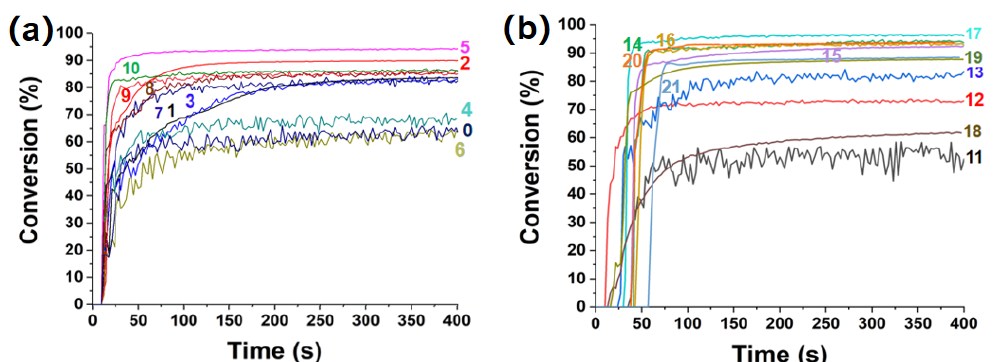
Figure 1. Photopolymerization profiles of Ebecryl 40 (conversion rate of C = C bonds vs irradiation time) initiated by iodonium (Iod) and amine (EDB) upon exposure to LED@405nm under air in the presence of dyes 1 – 21 for curves 1–10 ( a ) and 11–21 ( b ) at the same weight ratio: dye:Iod:amine = 0.1%:2%:2% in Ebecryl 40; the curve number indicated the investigated dye. The reference curve without dye is curve 0 for Iod:amine = 2%:2%. The irradiation starts for t = 10 s. Table 1. Summary of the final acrylate function conversions (FCs) at 405 nm for Ebecryl 40 using three-component photoinitiating systems: dyes (0.1%, w/w), iodonium salt (Speedcure 938, 2%, w/w) and amine (Speedcure EDB, 2%, w/w).